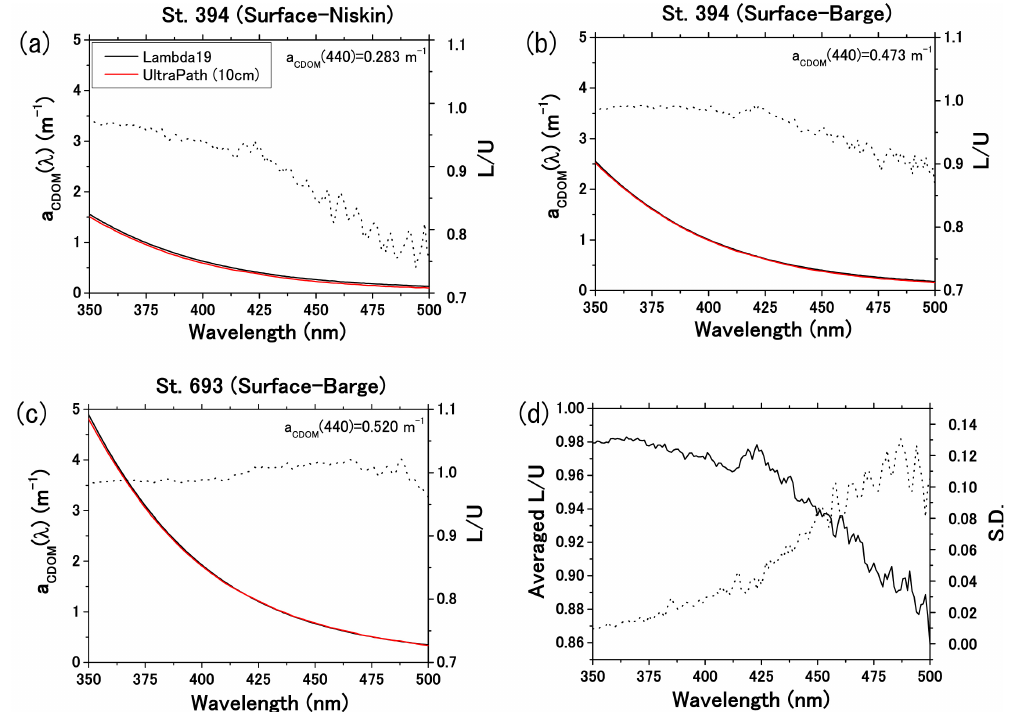
Fig. A2. Comparison of CDOM absorption spectra between a liquid waveguide system (UltraPath) and a traditional spectrophotometer (Lambda 19) at (a) station 394 (water from Niskin), (b) station 394 (water from barge), and (c) station 693 (water from barge). (d) average value of the ratio (L/U) between values measured with the Lambda 19 spectrophotometer (L) and with the Ultrapath (U) and its standard deviation (dotted curve) within the spectral range from 350 to 500nm (where the spectral slope of CDOM absorption is